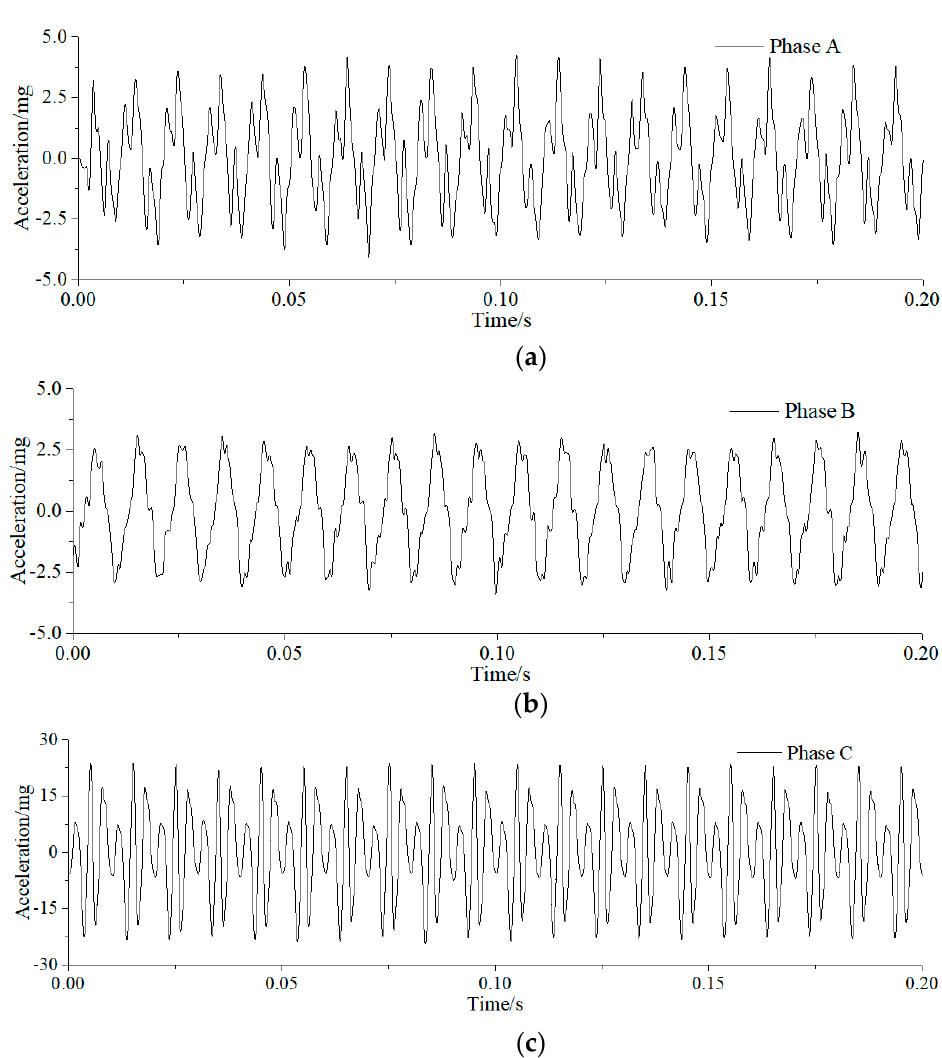
Figure 17. Time - domain waveform of isolation switch. ( a ) Phase A; ( b ) Phase B; ( c ) Phase C.